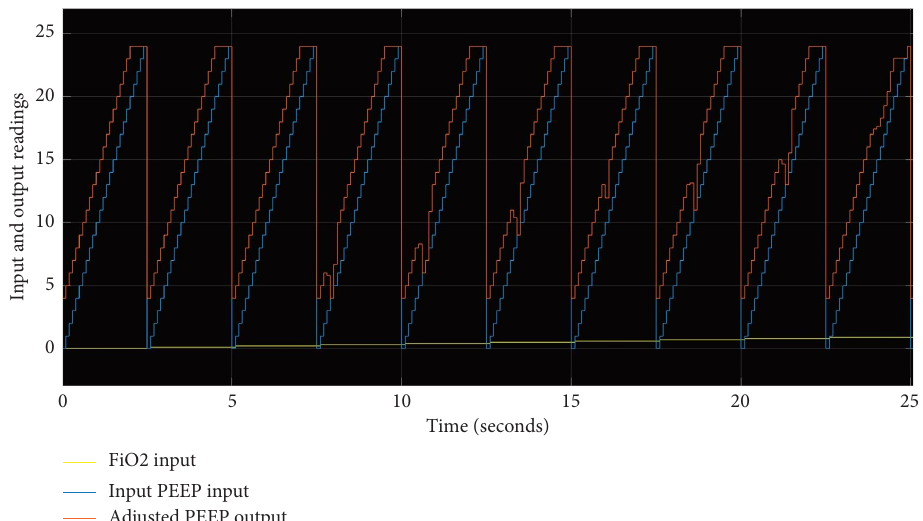
Figure 17: FiO 2 input, non-fuzzifed initial low PEEP input, and fuzzifed adjusted PEEP output graph.